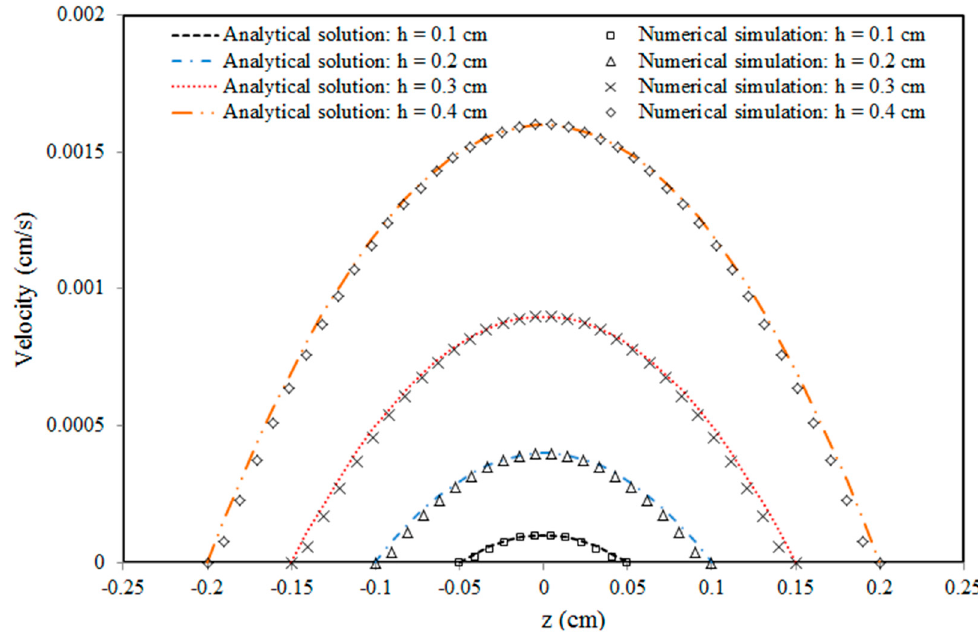
Figure 4. The comparison between the analytical solution and numerical simulation for fluid flow through the parallel plate model with different apertures.